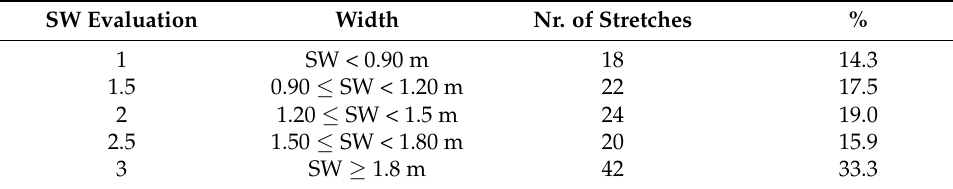
Table 3. Sidewalk width (SW).